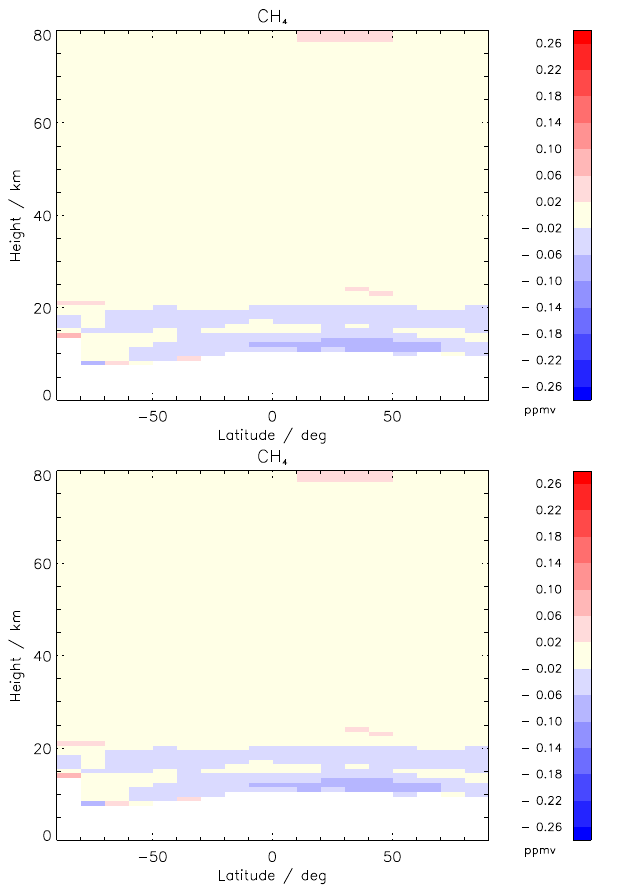
1 Figure 8. As Fig. 3, but difference retrieval with joint fit of HNO 3 1 Figure 9. Mean vertical resolution in km for profiles from reduced- and H 2 O minus reference with old setup. resolution spectra (versions V5R_CH4_224 and V5R_N2O_224). The upper panel shows results for CH 4 ; the lower panel shows re- sults for N 2